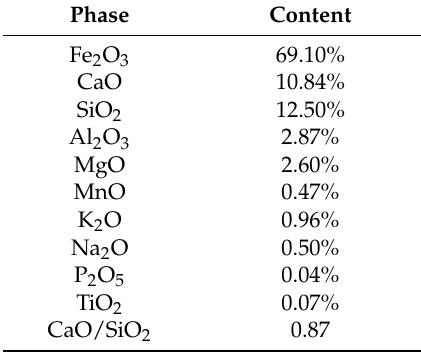
Figure 18. Scheme of the device used in the experiments, distances in millimeters. Table 11. Chemical composition of the iron ore sinter (Voestalpine sintered) determined using X-ray